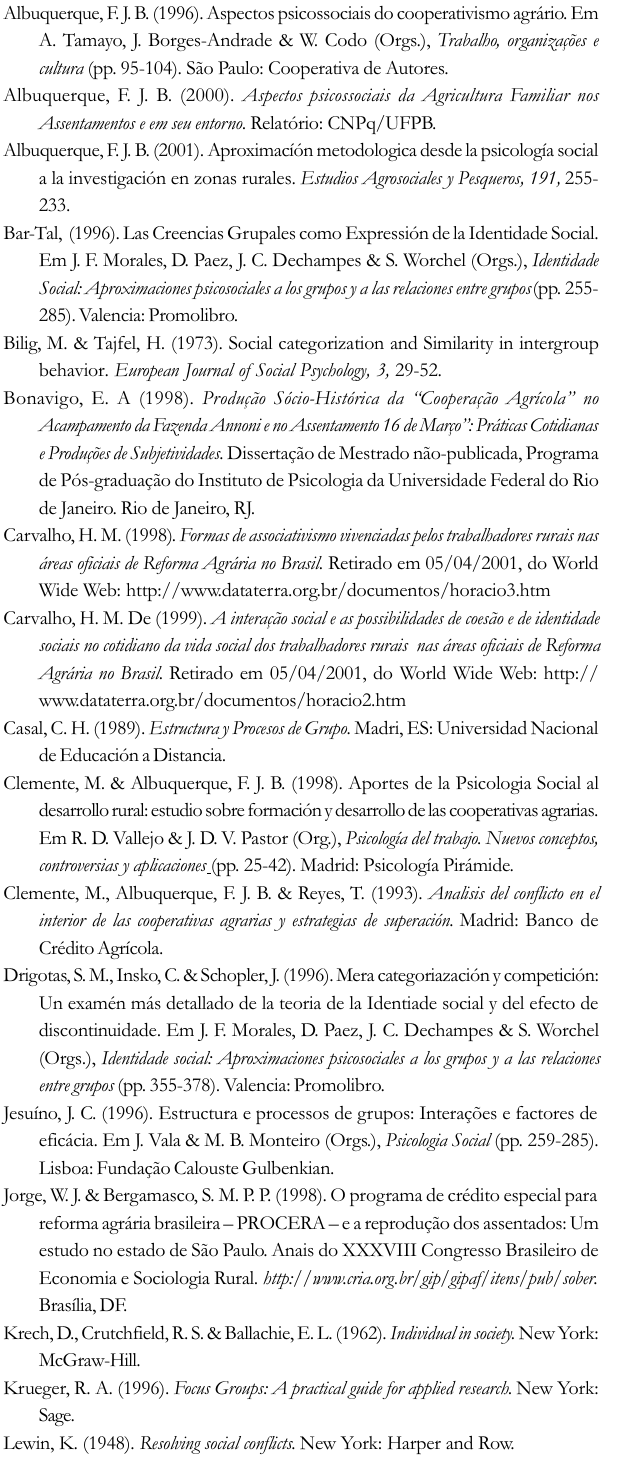
AnÆlise Psicossocial do Assentamento e seu